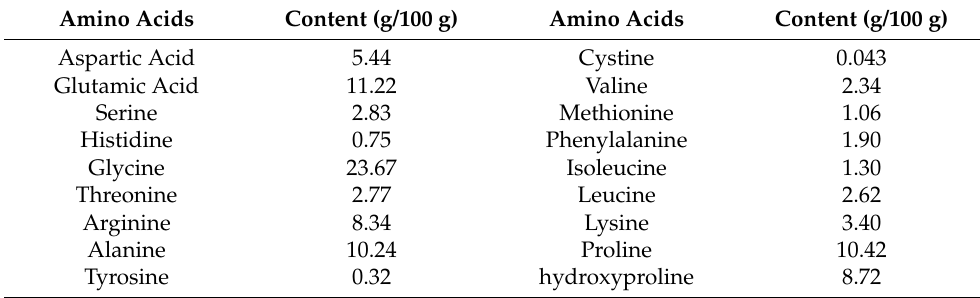
Table 1. The Amino Acids Composition of